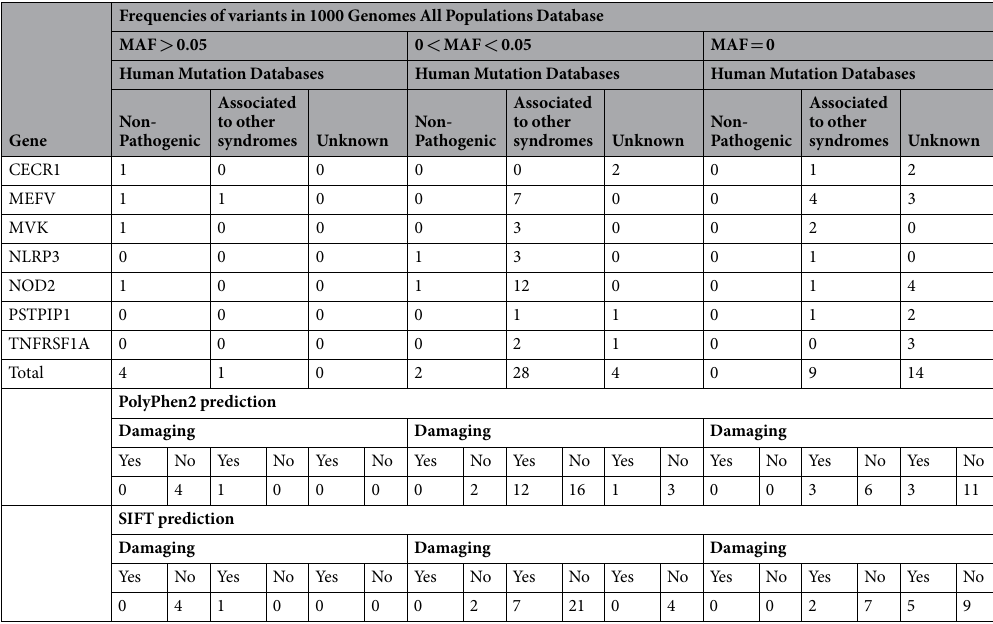
Table 1. Classification of the variants found in the present study in BD patients. The number of variants in each group is displayed.